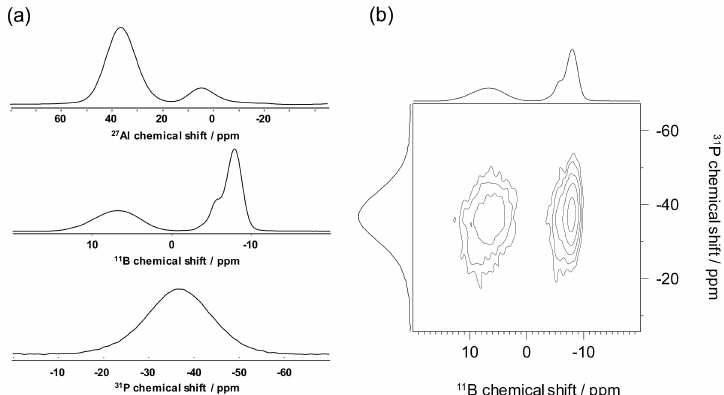
Figure 10. ( a ) 1D 27 Al, 11 B and 31 P, ( b ) 2D 11 B( 31 P) D-HMQC obtained at 18.8 T obtained on Al 2 O 3 -B 2 O 3 -P 2 O 5